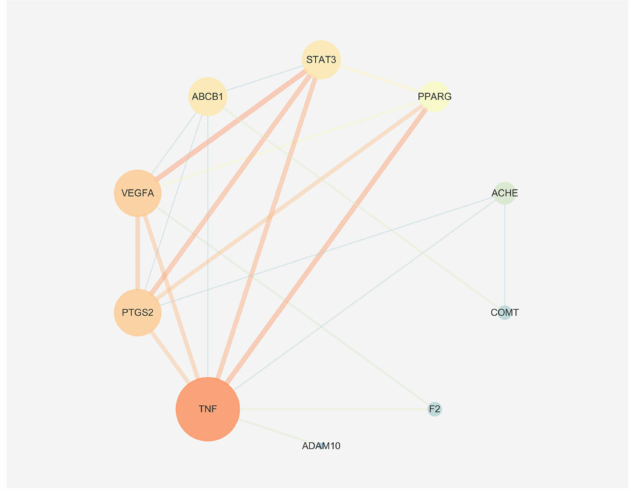
Figure 11. PPI network and node degree arrangement of common targets.